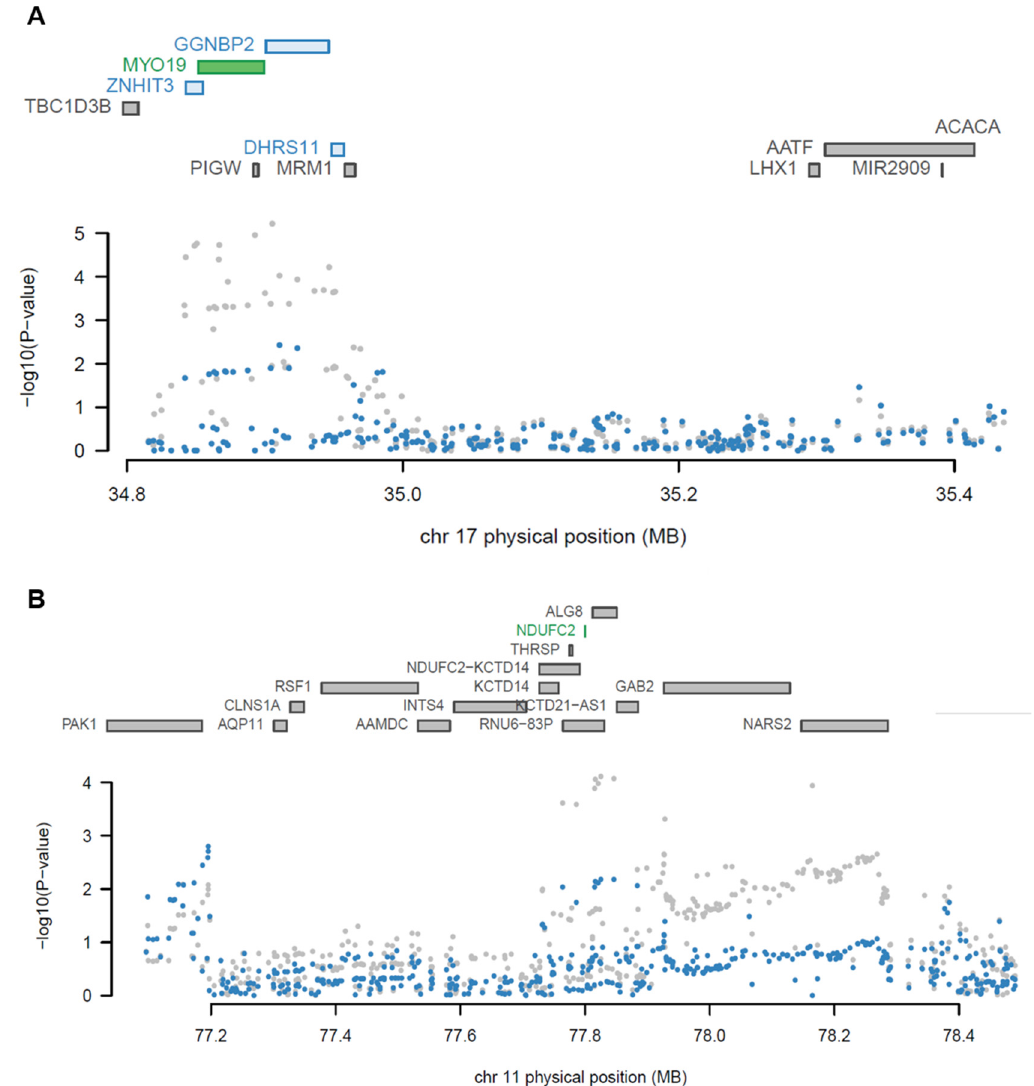
Figure 4. Regional association plots showing the jointly significant TWAS genes. ( A ) A regional association plot at chromosome 17 from blood tissue of YFS. ( B ) A regional association plot at chromosome 11 from the brain cortex of GTEx. Color bars on the top panel show all of the protein-coding genes and/or TWAS genes. Jointly significant genes are highlighted using green bars while marginally significant genes are highlighted using blue bars. A scatter plot at the bottom shows a Manhattan plot of the GWAS data before (gray) and after (blue) conditioning on the independently significant genes. Table 2. Independent TWAS genes mapped to GWAS loci reported by GWAS catalog.